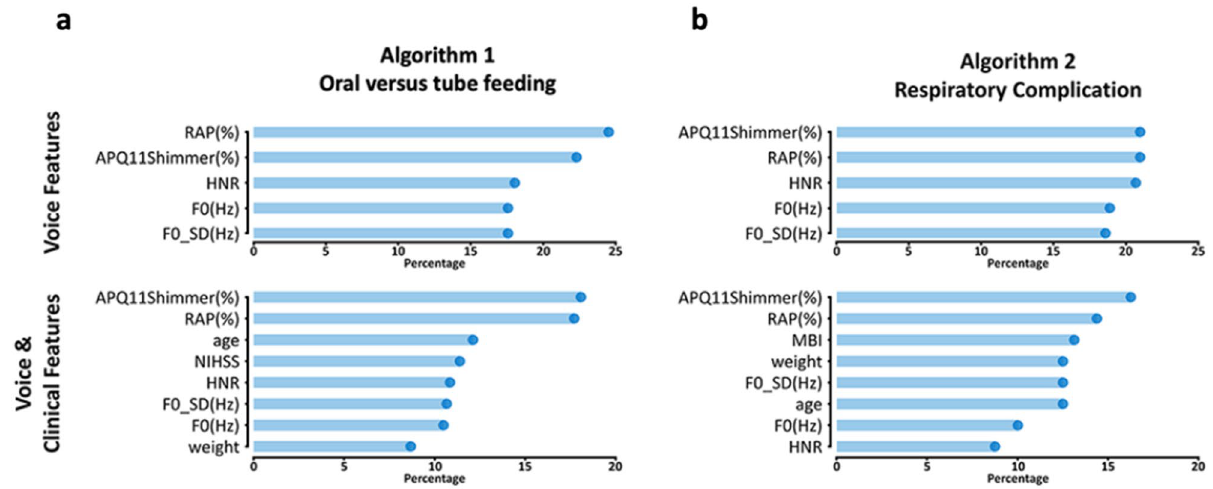
Figure 4. Feature importance analysis. Feature importance analysis from the XGBoost with plots demonstrating that APQ11Shimmer and RAP values are the major features even after including the clinical variables in ( a ) classifying those with tube feeding and ( b ) at risk of respiratory complications. XGBoos t extreme gradient boosting, RAP relative average perturbation, APQ amplitude perturbation quotient, HNR harmonic